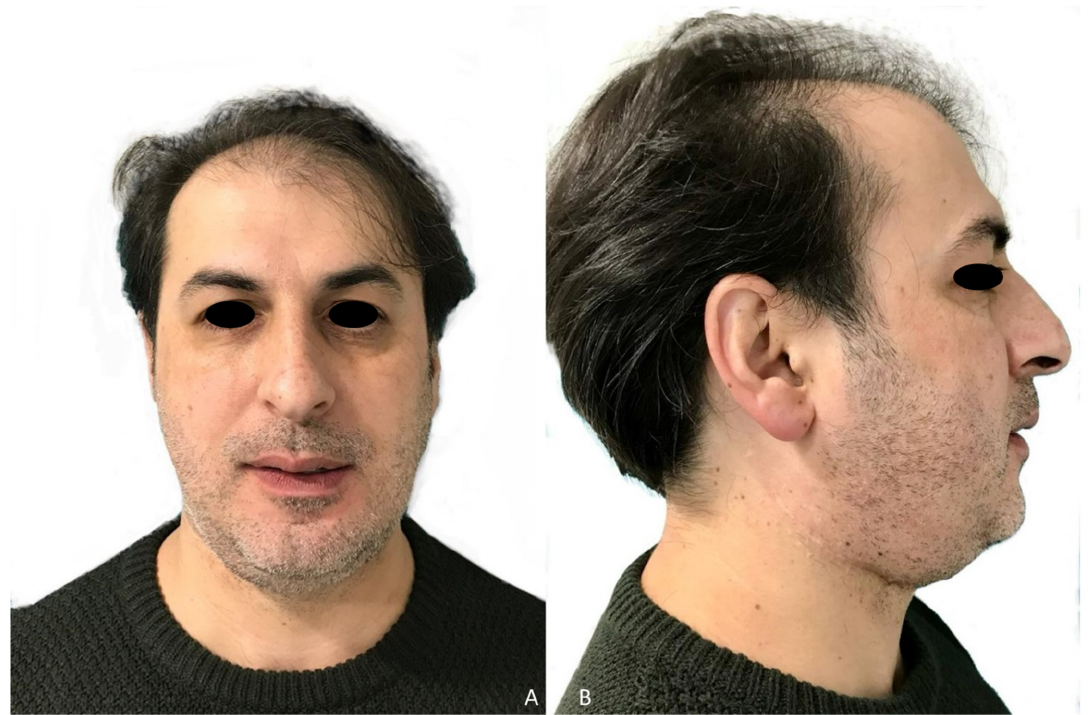
Figure 12. Final aesthetic result. ( A ) Aesthetic result with mandibular symmetry. ( B ) Aesthetic profile with a good projection of the lower facial third.